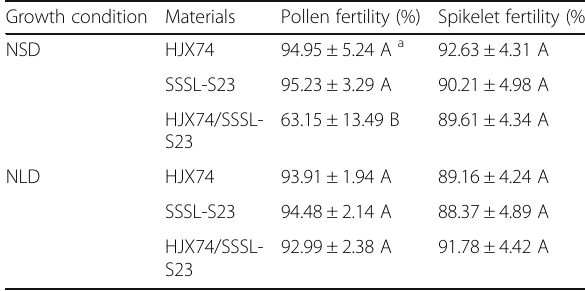
Growth condition